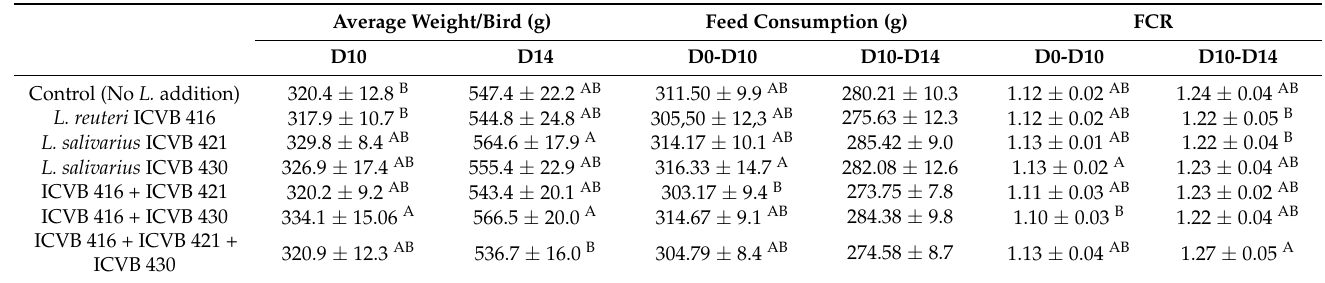
Table 3. Effects on chicken weight, feed consumption and FCR (Feed Conversion Ratio) after Lactobacillaceae supplementation. FCR is the ratio of measuring the efficiency with which the bodies of livestock convert animal feed into the desired output.